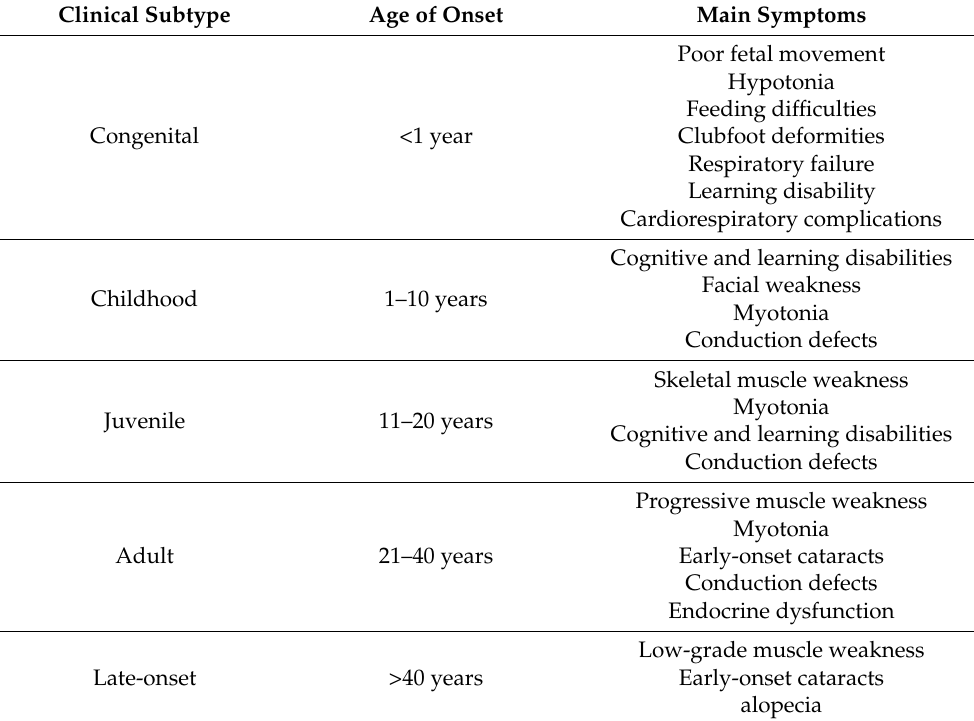
Table 1. Clinical manifestations of the different DM1